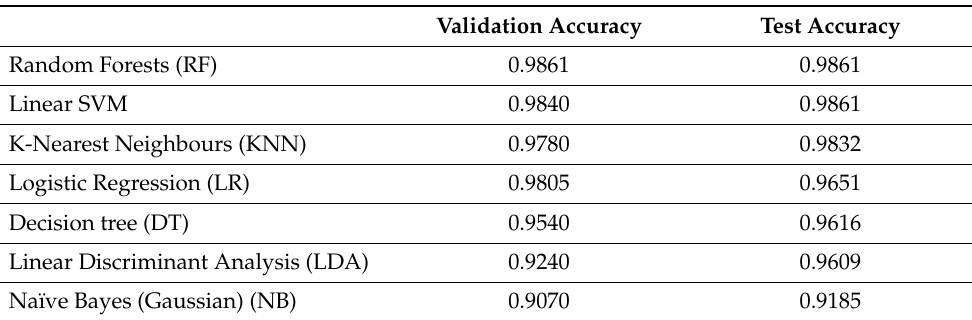
Figure 7. ROC plot for SGD classifier (micro-averaged 79%). Table 4. Accuracy of different machine learning algorithms on test (validation) set and test set for best-performing parameter